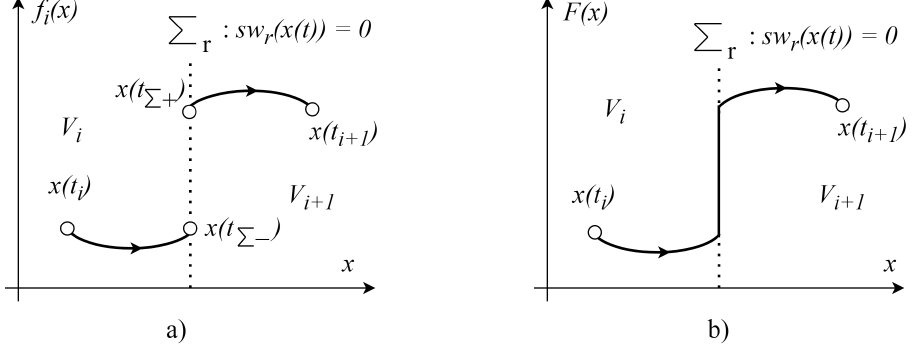
Figure 4. ( a ) Graph of the function f ( x ) ; ( b ) F ( x ) at t 0 goes over the instant t Σ with a smooth jump up to the instant T